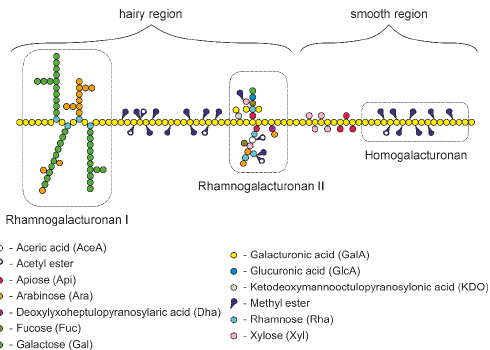
Figure 1. Scheme of the general structure of pectins (based on [1]).